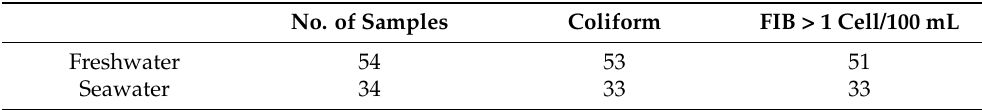
Table 2. Overview of Fresh- and Seawater sample contaminated with >1 coliform or fecal coliform bacteria in 100 mL of water